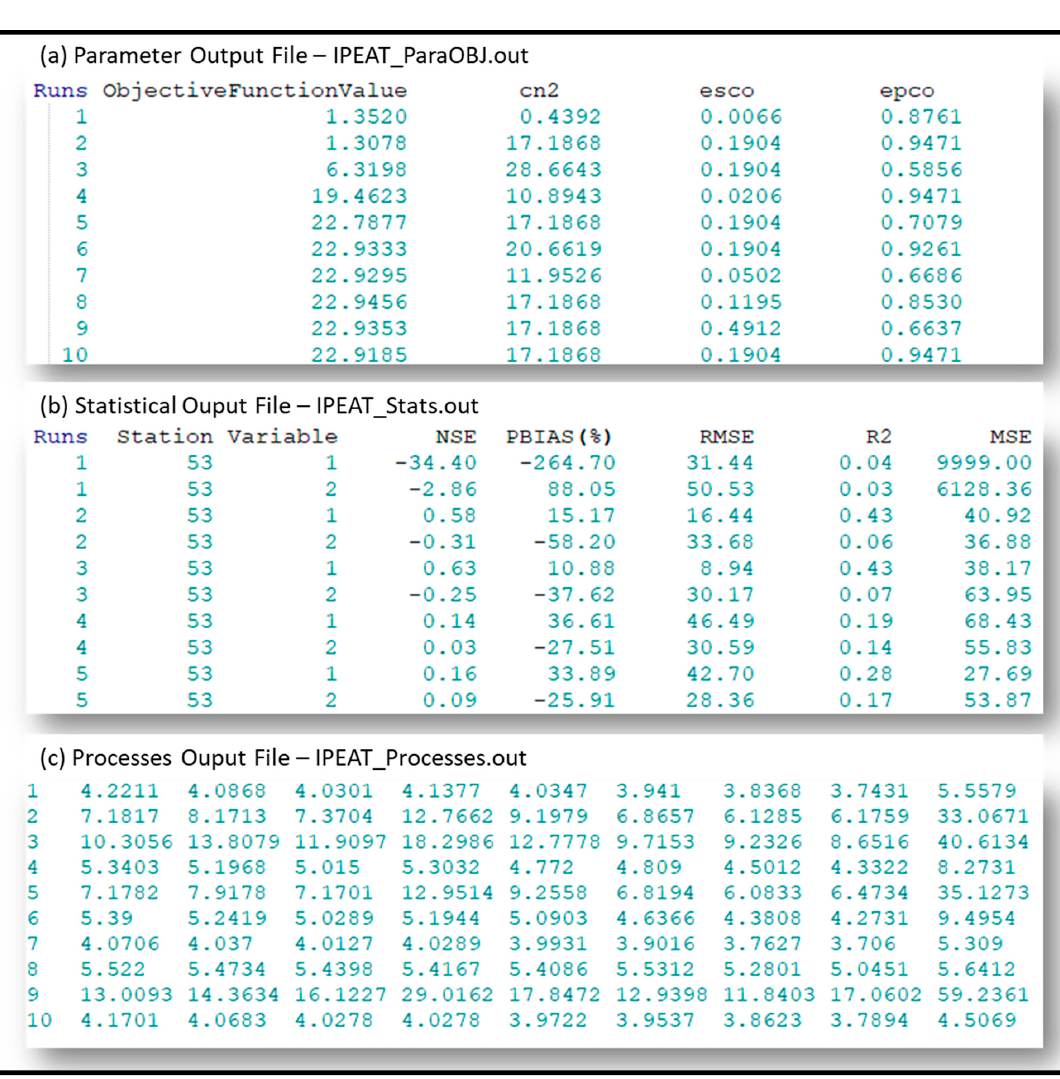
Figure 4. Illustration of IPEAT+ output files: ( a ) Parameter outputs for calibration parameter sets and the corresponding objective function values; ( b ) statistical results of individual output variable in each runs (NSE: Nash-Sutcliffe Efficiency Coefficient; PBIAS: Percent Bias; RMSE: Root Mean Square Error; R2: Coefficient of Determination; and, MSE: Mean Squared Error); and, ( c ) modeling output processes of targeted output variable.